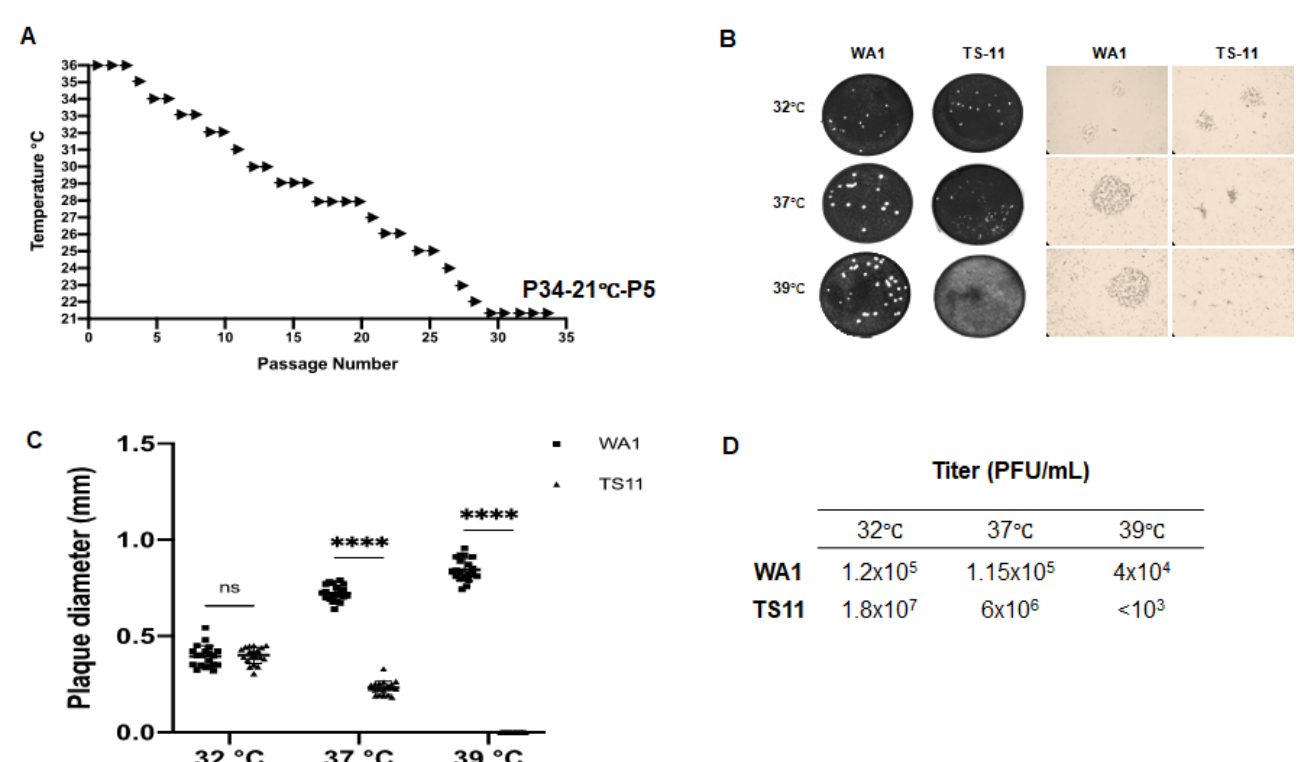
Figure 1. Generation of a cold-adapted/temperature-sensitive SARS-CoV-2-WA1 mutant (TS11). ( A ) Overview of the passaging history that generated the cold-adapted TS11 strain from SARS-CoV-2 WA1. ( B ) Representative images of the viral plaques formed by WA1 and TS11 cultured at different temperatures (32 °C, 37 °C and 39 °C): left panel shows plaque appearance by eye, and the right panel shows the plaques observed under a light microscope. ( C ) The diameter of plaques of WA1 and TS11 cultured at 32 °C, 37 °C and 39 °C. The diameter means of 20 plaques of TS11 and WA1 viruses were compared by Student’s t test (****, p < 0.001; ns, not significant). ( D ) The efficiency of plating (or plaque forming efficiency) of WA1 and TS11 virus stock at 32 °C, 37 °C and 39 °C.